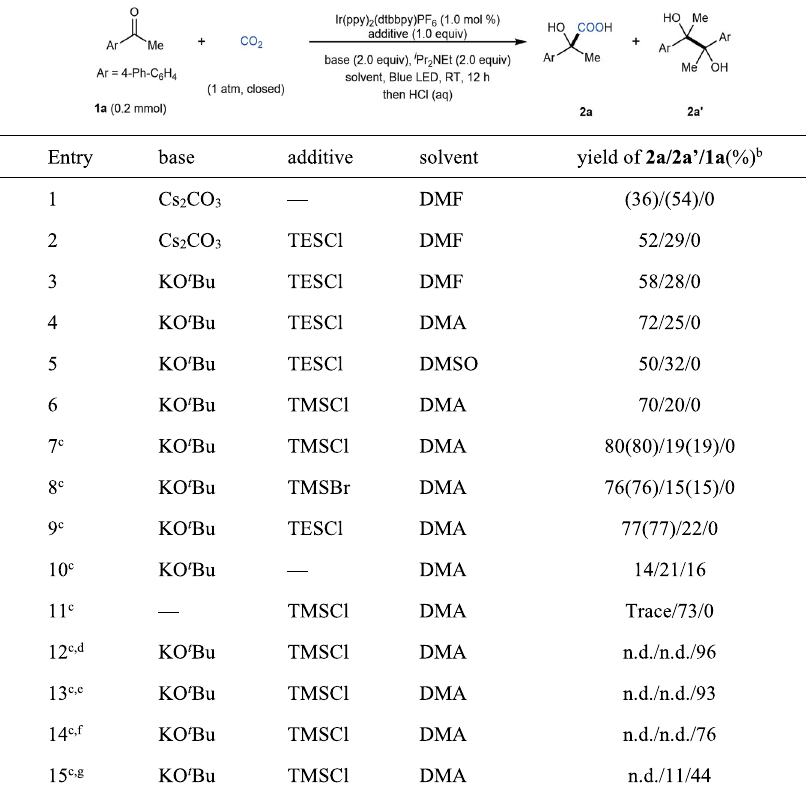
NATURE COMMUNICATIONS| (2021) 12:3306